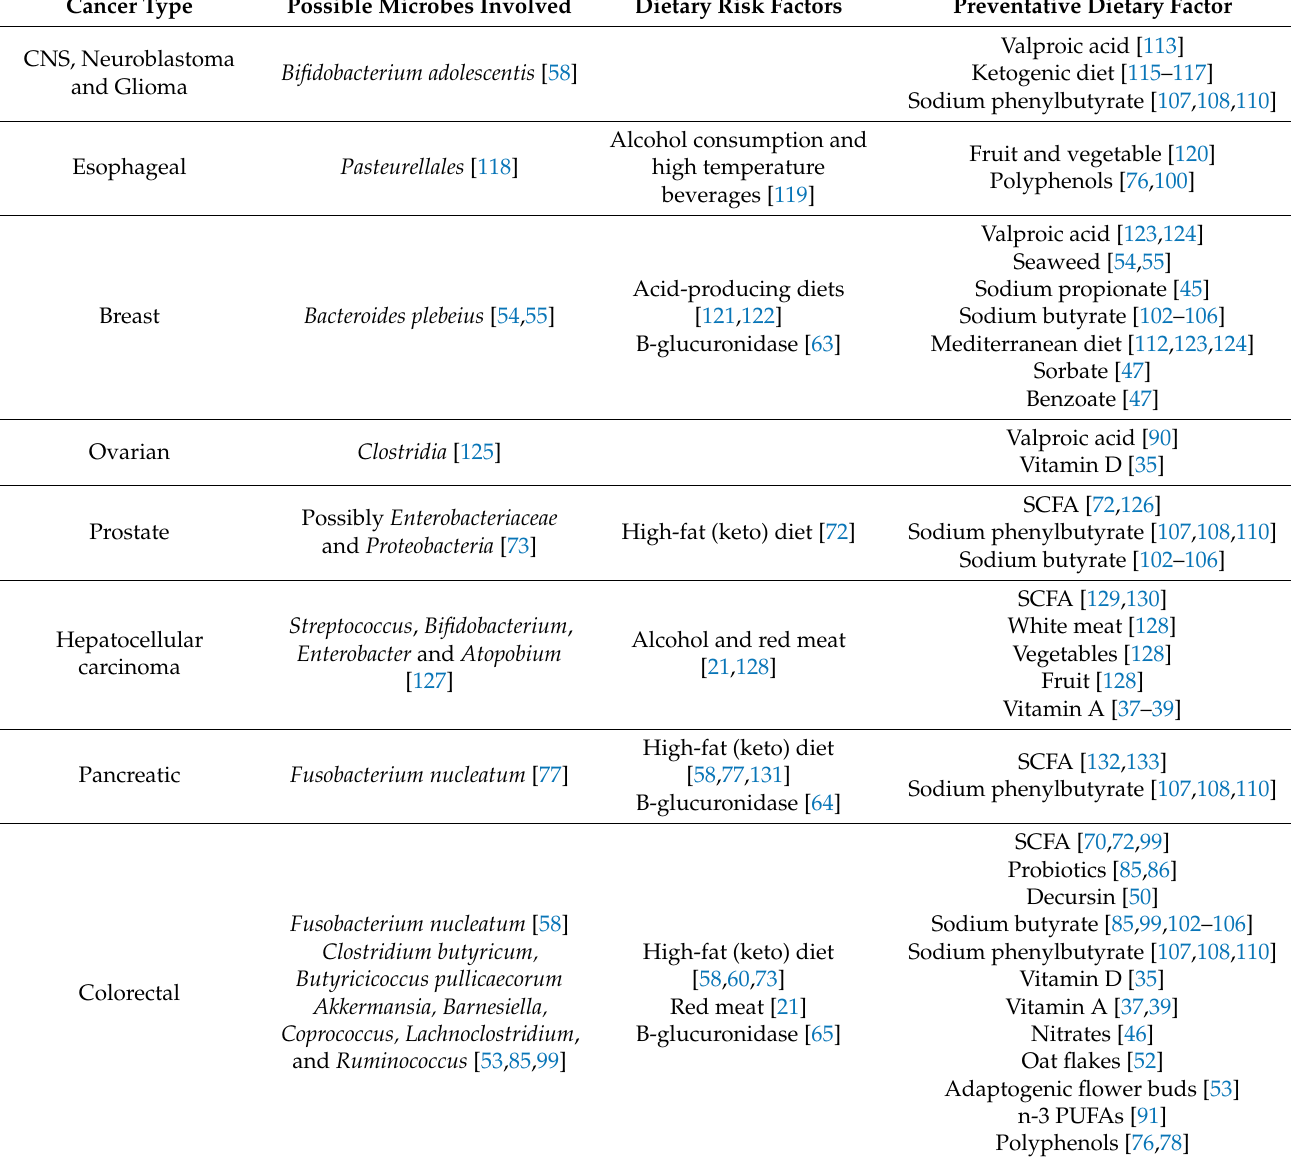
Table 1. Examples of recent links between cancer, microbes, and dietary